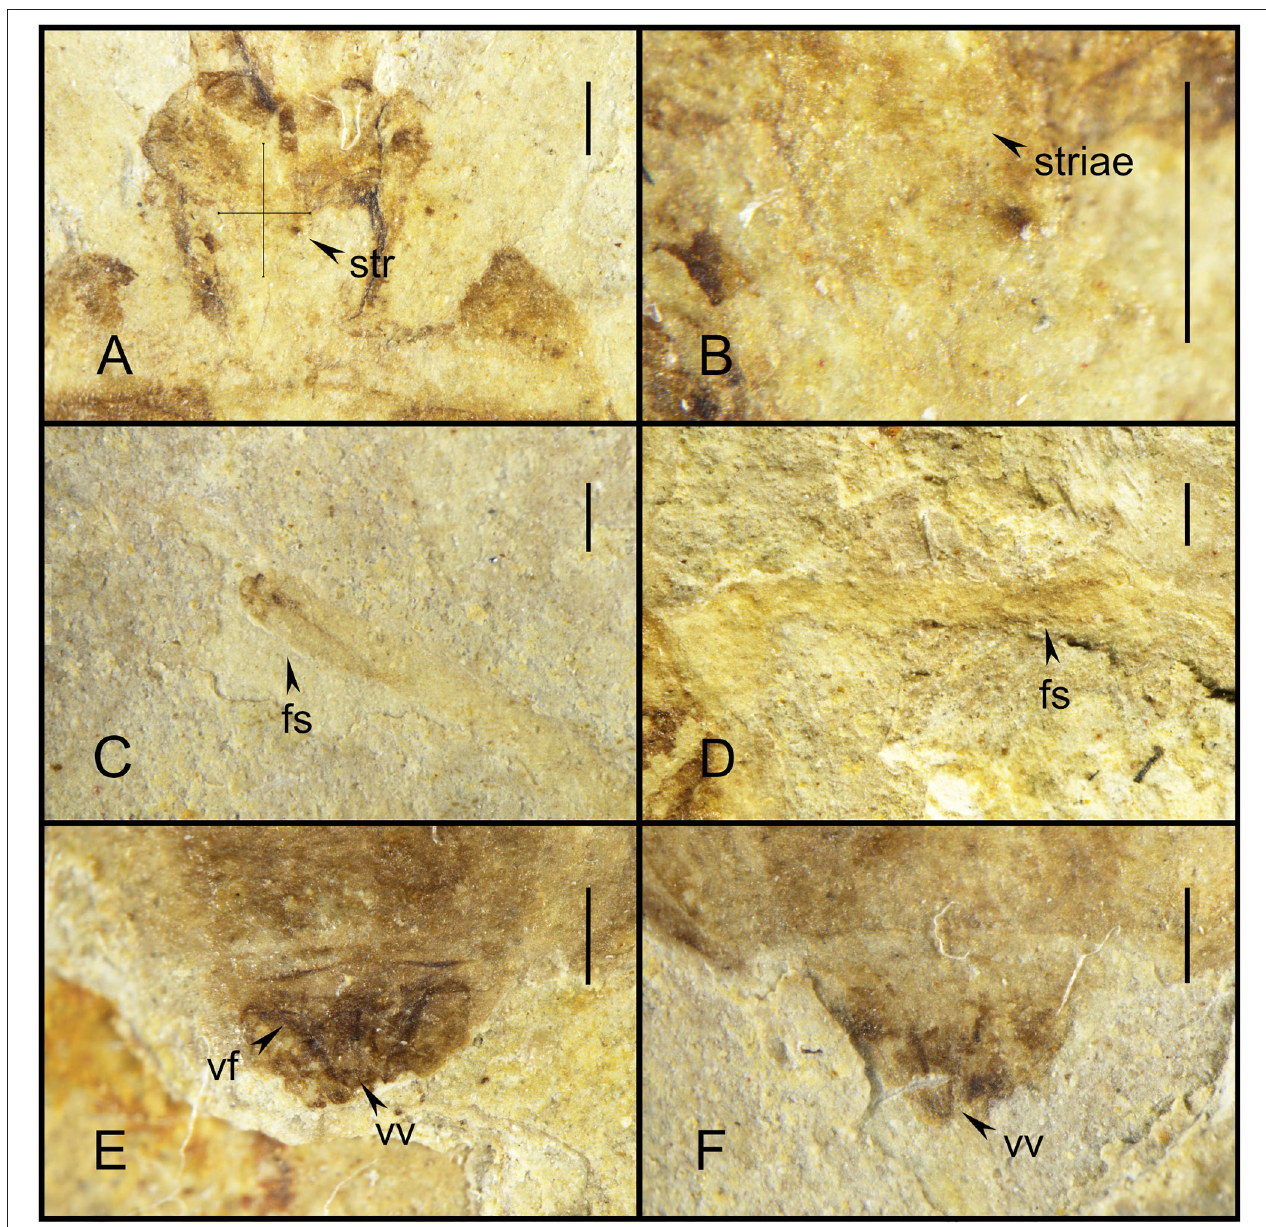
FIGURE 3 | Simplicivenius rectidorsius gen. et sp. nov. photographs with morphological details, holotype. CNU-HET-LB2022002. (A) Conservation range of stridulitrum. (B) Structures of striae. (C) Fossula spongiosa on fore tibia. (D) Fossula spongiosa on mid tibia. (E) Female genitalia in dorsal view. (F) Female genitalia in ventral view. Scale bars = 0.5mm. str, stridulitrum; fs, fossula spongiosa; vf, valvifer; vv,